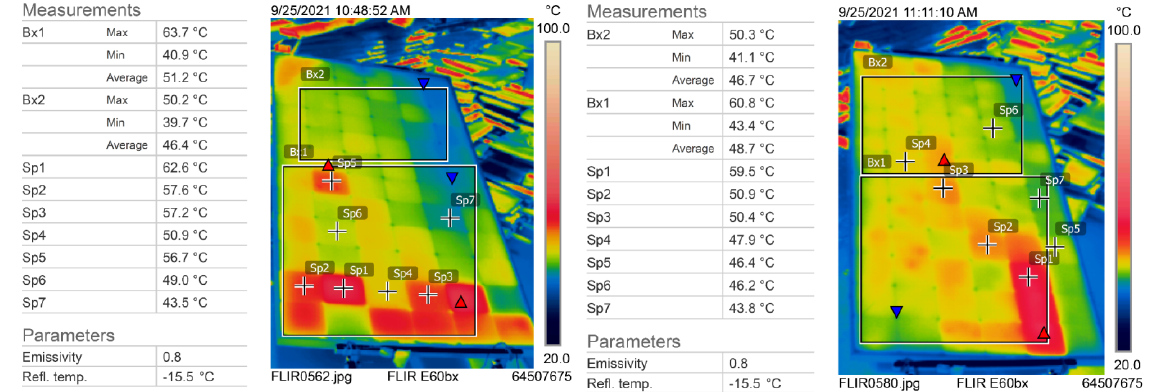
Figure 20. Thermographic analysis of module number 2 ( left ) and number 3 ( right ).